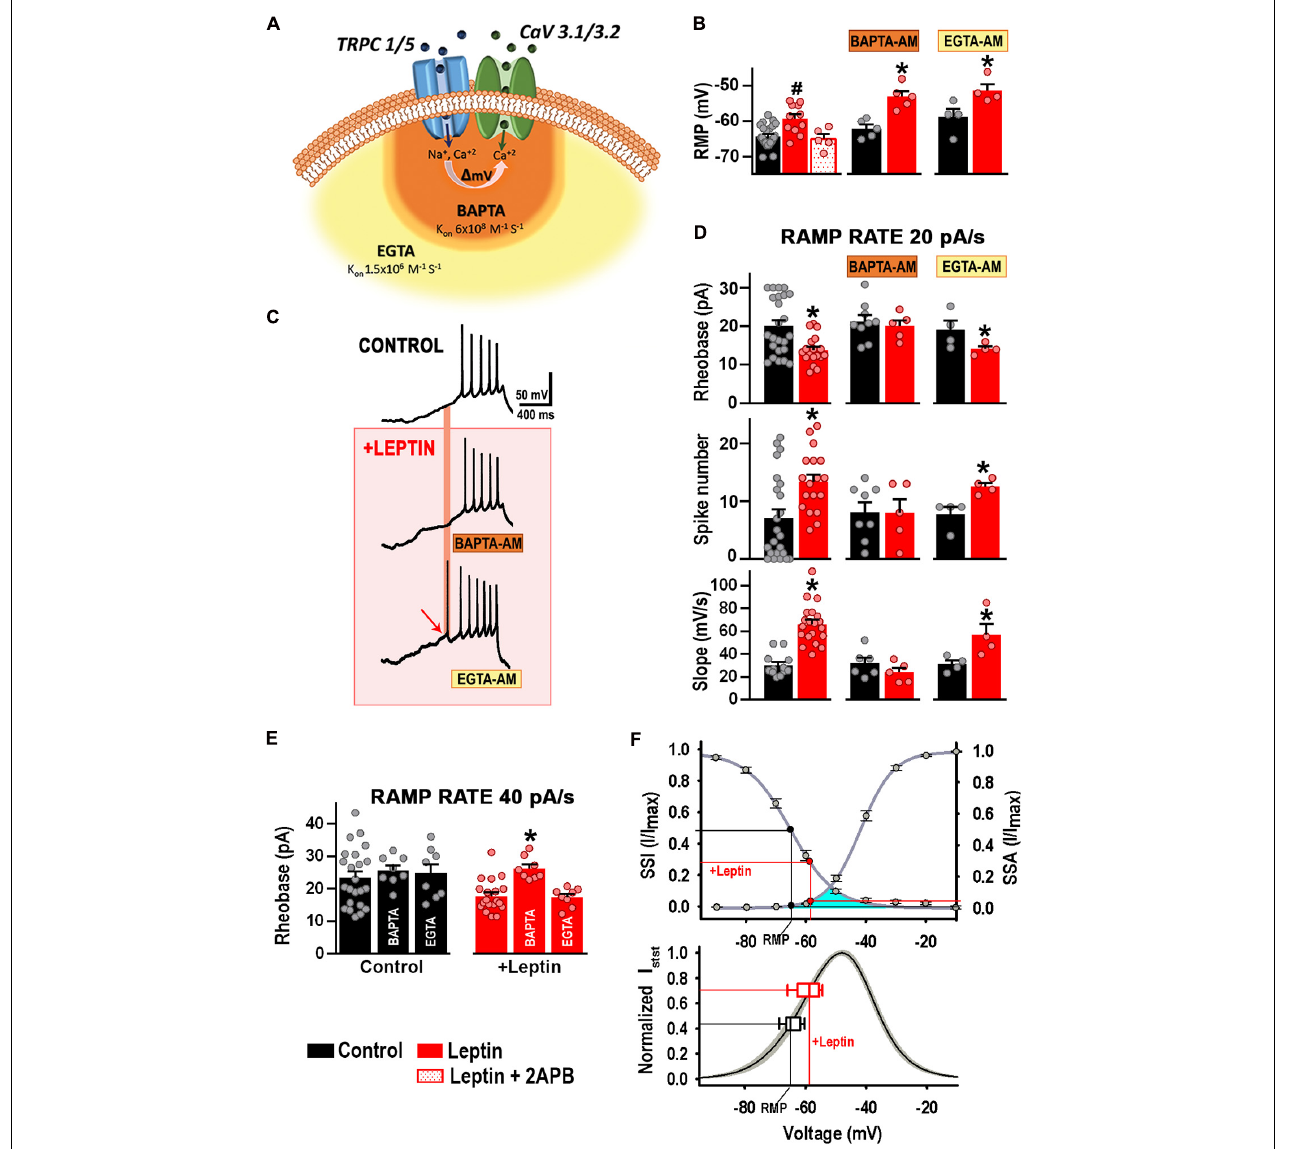
FIGURE 7 | Ca 2 + influx via TRPC1/5 depolarizes and recruits T-type channels. (A) Cartoon depicting T-type calcium channels co-exist in a complex with TRPC1/5. Membrane depolarization induced by TRPC channel-mediated cation influx recruits T-type channel activity. Chelation of Ca 2 + influx with a fast chelator that binds Ca 2 + closer to the mouth’s pore (BAPTA-AM, K ON = 6 × 10 8 ) is represented in orange. Chelation of Ca 2 + influx with a slower chelator (EGTA-AM, K ON = 1.5 × 10 6 ) is represented in light orange. (B) Resting membrane potential (RMP) from control ( n = 24) and leptin-treated neurons in the absence ( n = 11) or presence of 2APB ( n = 5). Values for control and leptin-treated neurons were reproduced from (A) for comparison. Cultured hypothalamic neurons were incubated with either 10 µ M BAPTA-AM ( n = 5) or EGTA-AM ( n = 4) for 30 min at 37 ◦ C prior to whole-cell current clamp to assess leptin-mediated effects on the RMP. # Significantly different from others, P < 0.05, ANOVA, F ( 2 , 37 ) = 8.927. *Significantly different from control, P < 0.05, t -test. BAPTA: t = 4.743, df = 8. EGTA: t = 2.579, df = 6. (C) Example traces of APs elicited by a 20 pA/s ramp protocol under control conditions (top trace), and after the addition of 100 nM leptin in the presence of BAPTA (middle) or EGTA (bottom). (D) Rheobase, AP number, and slope values elicited by 20 pA/s ramps for each treatment ( n = 4–24). *Significantly different from control, P < 0.05, t -test. Rheobase: t = 3.285 (df = 40, control), t = 0.4757 (df = 12, BAPTA incubation), t = 2.019 (df = 6, EGTA incubation). AP number: t = 3.065 (df = 39, control), t = 0.044 (df = 11, BAPTA), t = 3.376 (df = 6, EGTA). Slope: t = 6.495 (df = 30, control), t = 1.245 (df = 9, BAPTA incubation), t = 2.446 (df = 6, EGTA incubation). (E) Rheobase values elicited by 40 pA/s ramps for each treatment ( n = 8–23). *Significantly different from others, P < 0.05, ANOVA, F ( 2 , 36 ) = 0.2637 for control neurons, F ( 2 , 32 ) = 12.36 for leptin-treated neurons. (F) T-type channel availability (SSI) and open probability (SSA) as function of voltage. SSI parameters: V 50 = –65.4 ± 1.0 mV, k = 7.1 ± 0.5 ( n = 21). SSA parameters: V 50 = –41.8 ± 0.7 mV, k = 5.2 ± 0.3 ( n = 22). Black circles indicate the availability and the open probability of T-type channels) at the indicated RMP. Red circles indicate steady sate properties at depolarized RMP after leptin (100 nM) incubation. Window current, underneath SSA and SSI curves is indicated in turquoise. Window currents were calculated for each recording neuron from the SSA and SSI curves fitted with the Boltzmann function ( n = 18, see section “Materials and Methods”); SEM is indicated in gray. The steady-state current was normalized to its maximum value (Normalized Isst). Steady-state current at the RMP (empty black box plot) increased after incubation with leptin (empty red box plot).